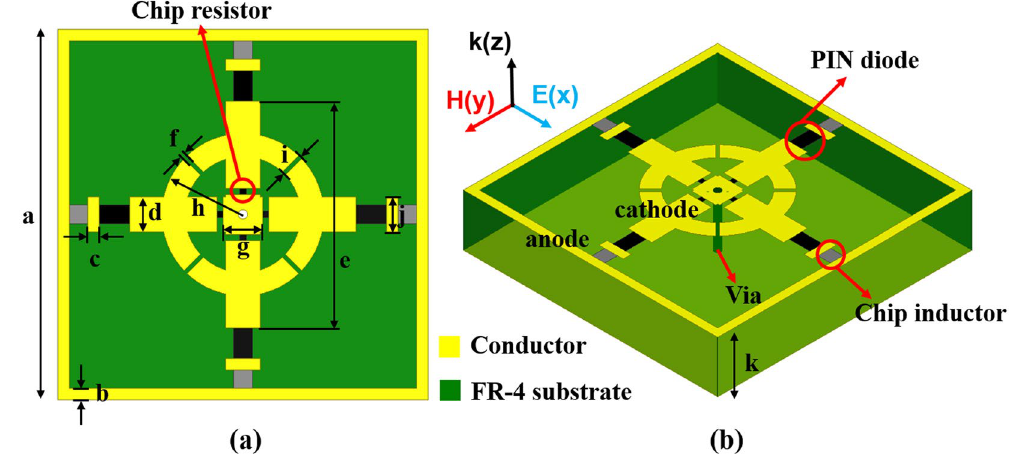
Figure 1. Geometry of the proposed absorber unit cell (a) top view, (b) 3-D view: a = 16 mm, b = 0.5 mm, c = 0.5 mm, d = 1.5 mm, e = 9.8 mm, f = 0.2 mm, g = 1.74 mm, h = 3.5mm, i = 1 mm, j = 1 mm, and k = 3.2